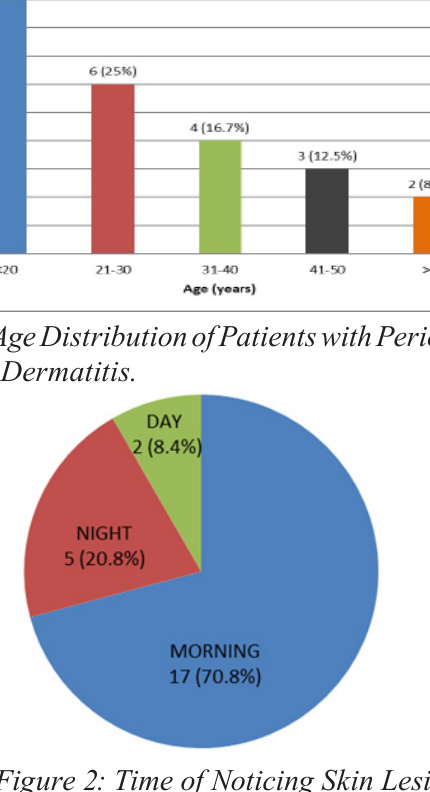
Figure 2: Time of Noticing Skin Lesions.